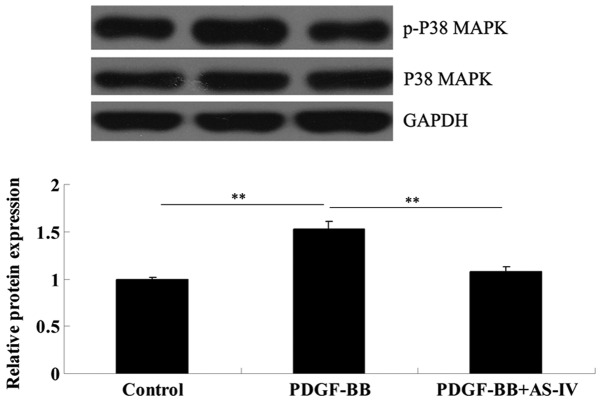
AS-IV suppressed PDGF-BB-induced activation of the p38 MAPK signaling pathway in HDVSMCs. Western blot analysis was performed to determine the protein expression levels of phosphorylated p38 MAPK, as well as the total p38 MAPK expression level, in each group. GAPDH was used as an internal reference. **P<0.01. Control, HDVSMCs without any treatment; PDGF-BB, HDVSMCs treated with PDGF-BB; PDGF-BB + AS-IV, HDVSMCs treated with PDGF-BB and AS-IV; AS-IV, astragaloside IV; PDGF, platelet-derived growth factor; HDVSMC, human dermal vascular smooth muscle cell; MAPK, mitogen activate protein kinase.